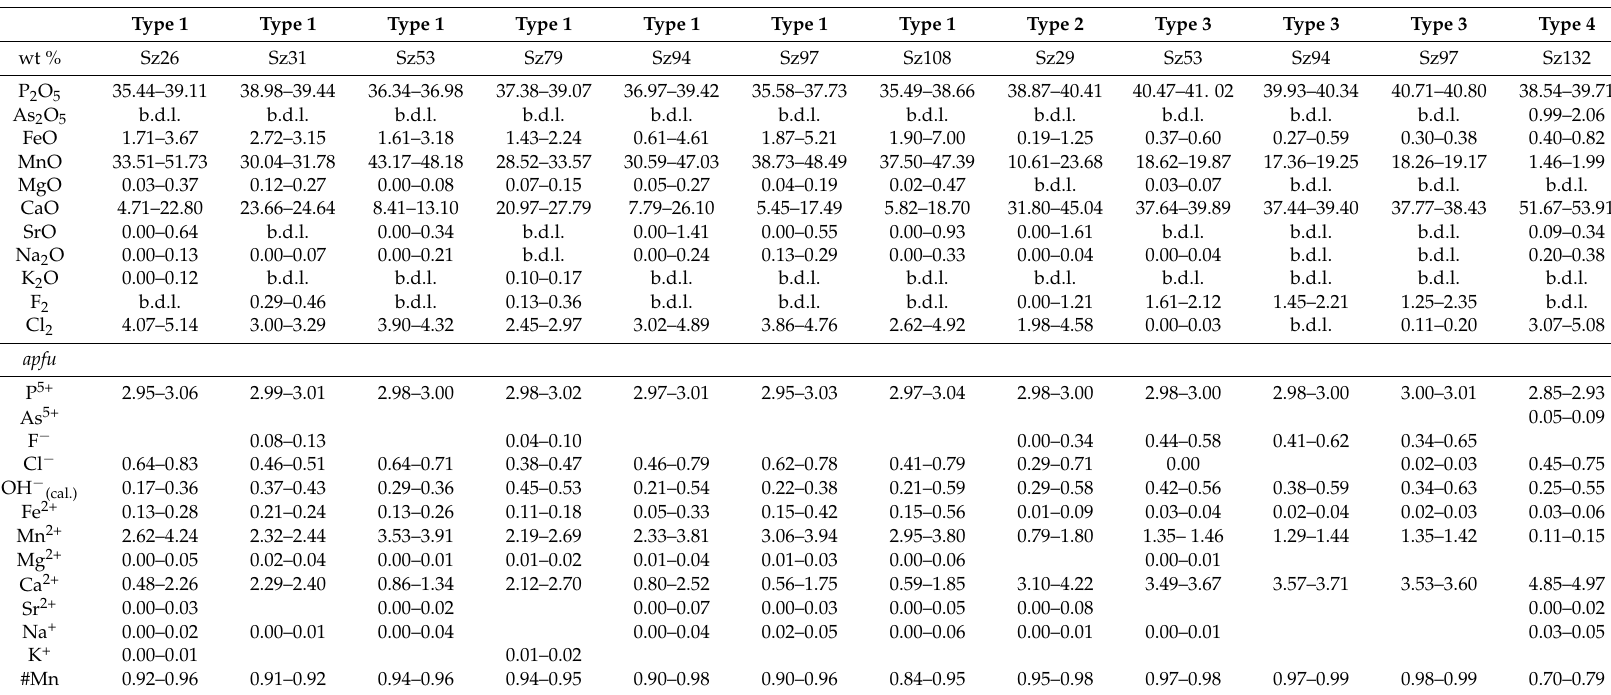
Table 1. Concentration ranges of selected elements from various textural-paragenetic types of apatites from the Szklary pegmatite. Sz26 = sample, #Mn = Mn/(Mn + Fe), b.d.l. = below detection limit. For definition of Types 1–4 see the